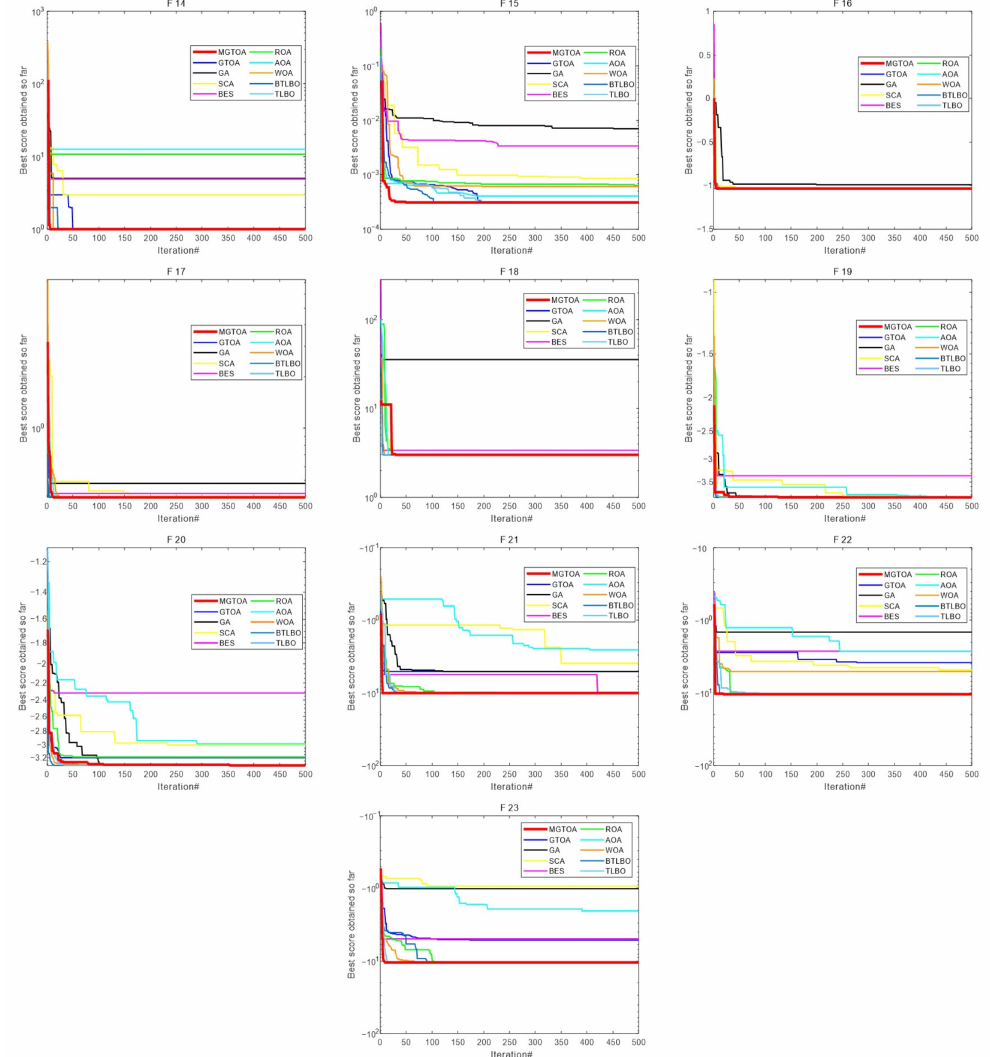
Figure 6. Convergence curves for the optimization algorithms for standard benchmark functions